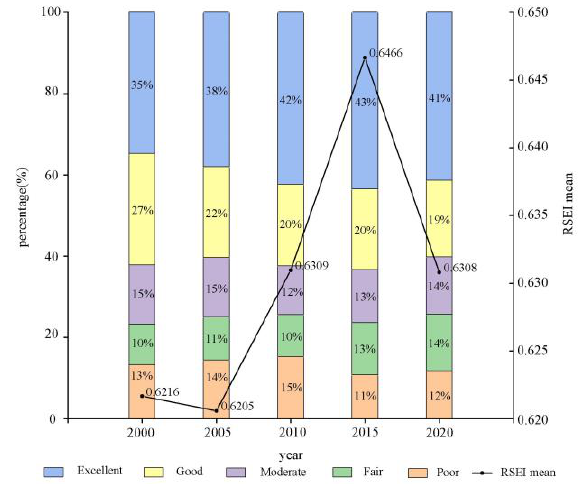
Figure 3. Statistics of RSEI area from 2000 to 2020.